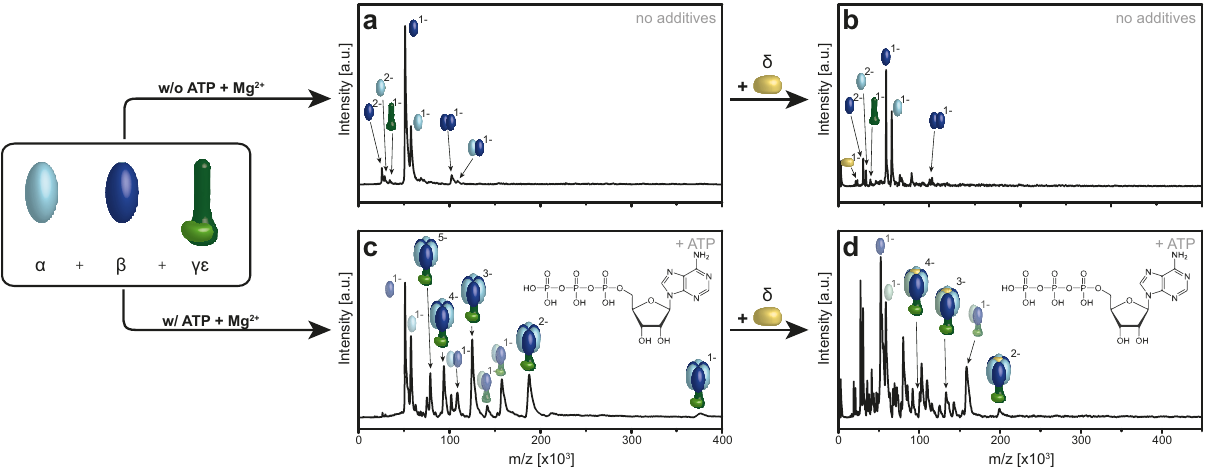
Fig. 3 ATP/Mg 2 + dependence of the in vitro assembly process of the full F 1 complex of Na + -F 1 F O - ATP synthases of A. woodii . The α - (light blue), β - subunit (dark blue), γε -complex (dark and light green) were incubated at 4 °C for 1 h either without ( a ) or with ( c ) 2 mM ATP and 2 mM MgCl 2 . Then the δ -subunit (yellow) was added ( b , d ). a , b No speci fi c assemblies into higher F 2 + . The appearance of the 1 -subcomplexes could be detected without ATP/Mg γ subunit alone is due to dissociation. (See as well Supplementary Fig. 8c). c , d In presence of ATP/Mg 2 + the fully assembled F fi ed 1 can be identi